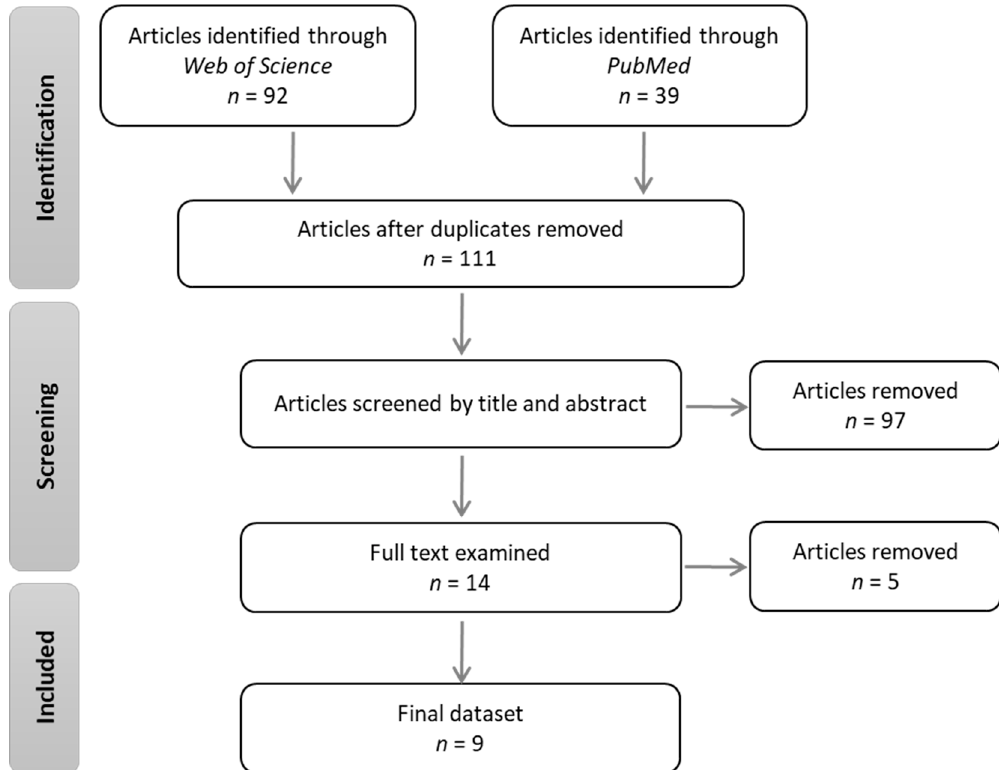
Figure 1. Preferred Reporting Items for Systematic Reviews and Meta-Analyses (PRISMA) flow diagram of study selection.